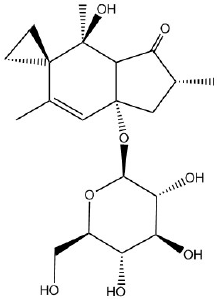
Figure 1. Chemical structure of ptaquiloside.